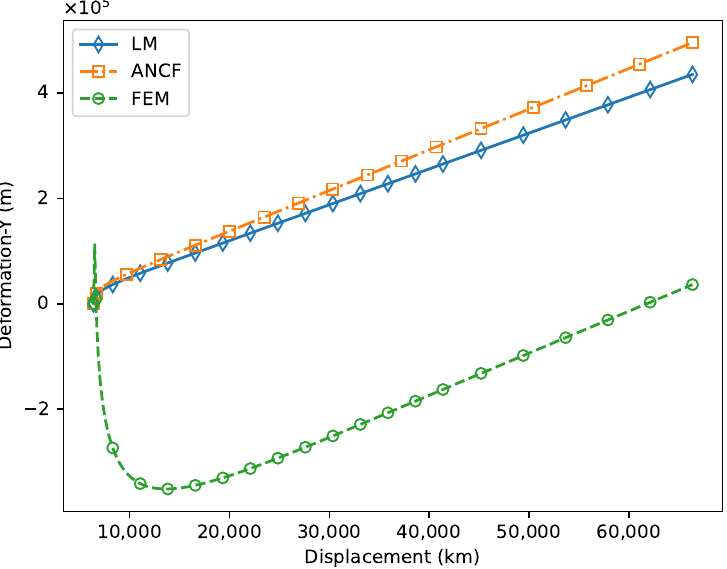
Figure 15. Example case of FEM